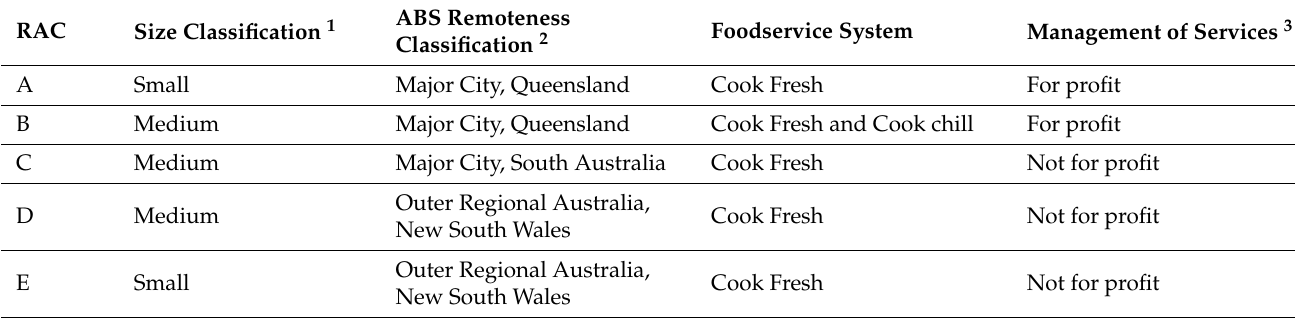
Table 4. Residential aged-care demographics.